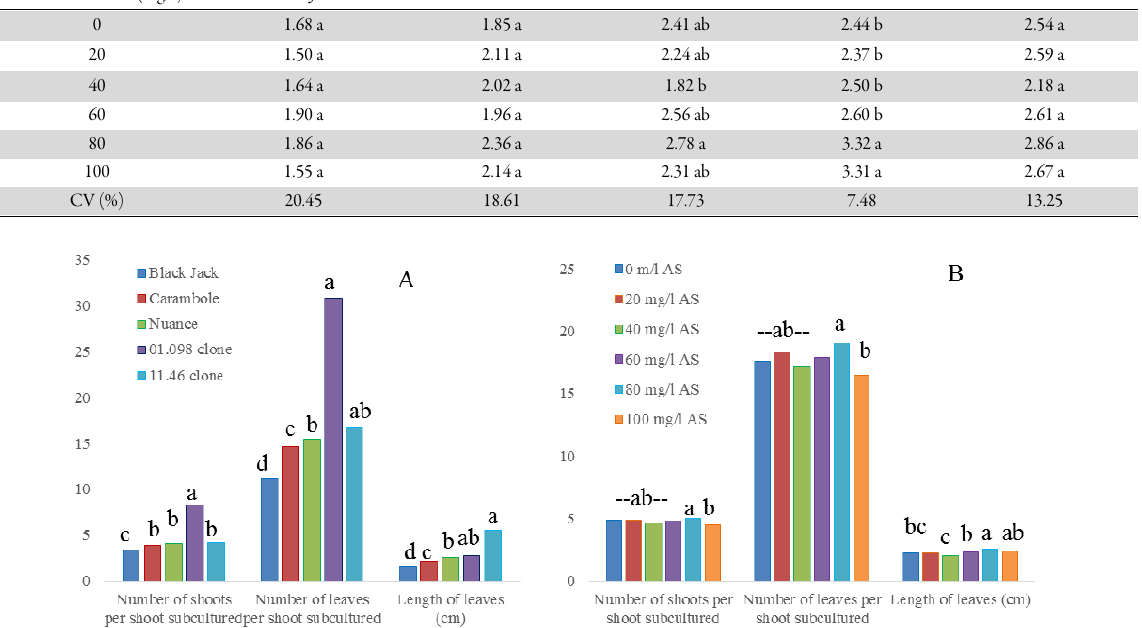
Table 7. Interaction effect of responses of varieties-clones and different concentrations of adenine sulphate on length of leaves (cm) AS concentration (mg/l)